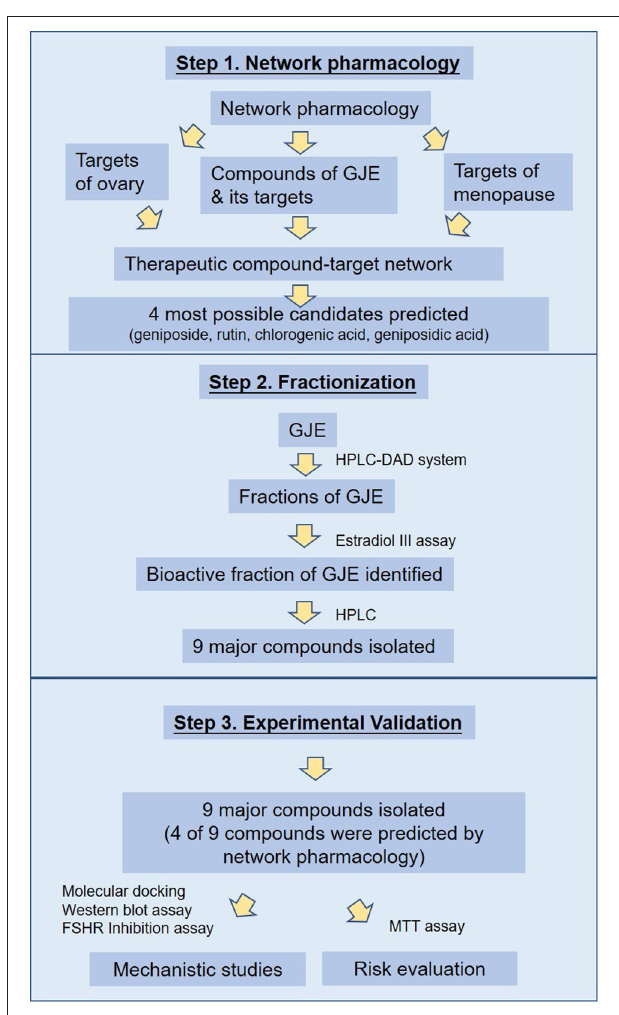
FIGURE 1 | Process